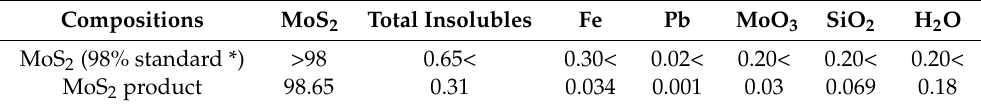
Figure 14. SEM − EDS ( a ) and Raman spectroscopy ( b ) characterization of the MoS 2 product. Table 3. Chemical compositions of the standard and MoS 2 product (wt.%).